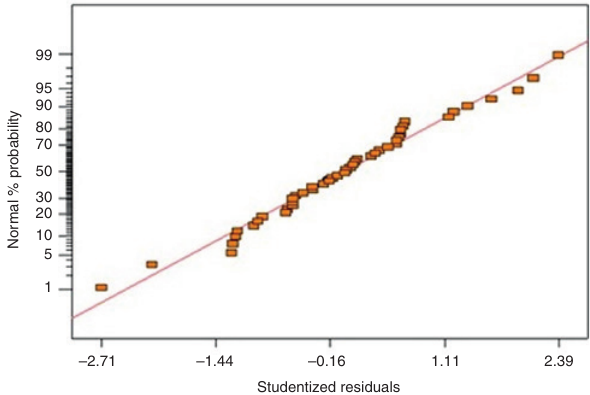
Figure 6: Normal probabilities of